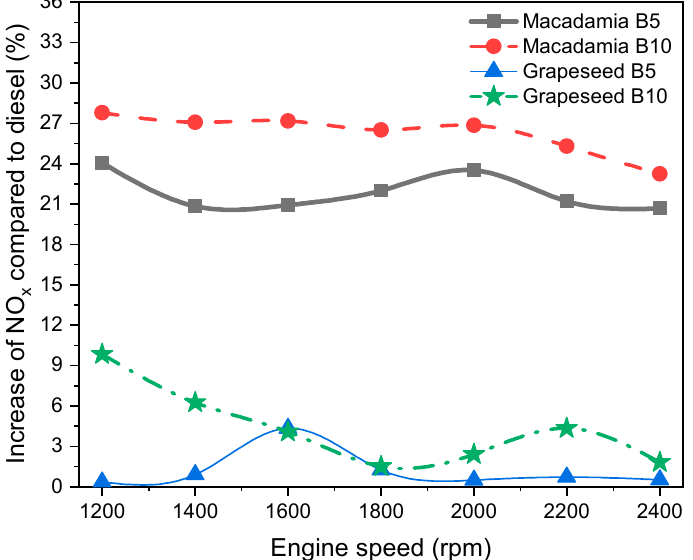
Figure 9. Effect on nitrogen oxide (NOx) emission compared to diesel using B5 and B10 biodiesel blends.